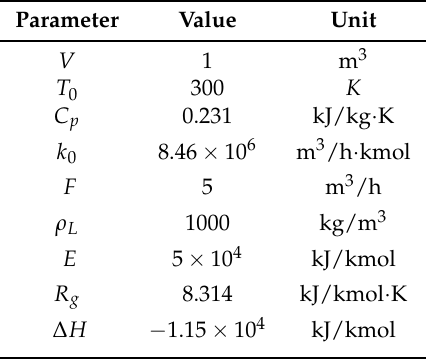
Table 2. Parameters for the continuous stirred tank reactor (CSTR)